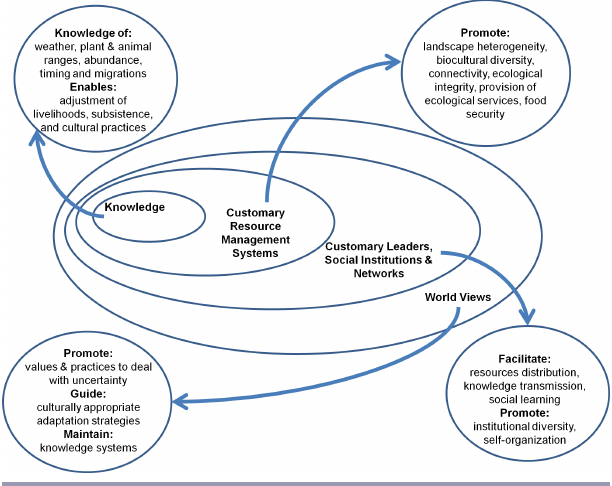
Fig. 1. Potential contributions of indigenous and local knowledge systems to social-ecological resilience to climate change. The concentric circle represents indigenous and local knowledge systems from knowledge to worldviews (adapted from Berkes 1999). The external circles identify ways local ecological knowledge systems can contribute to resilience in the context of climate